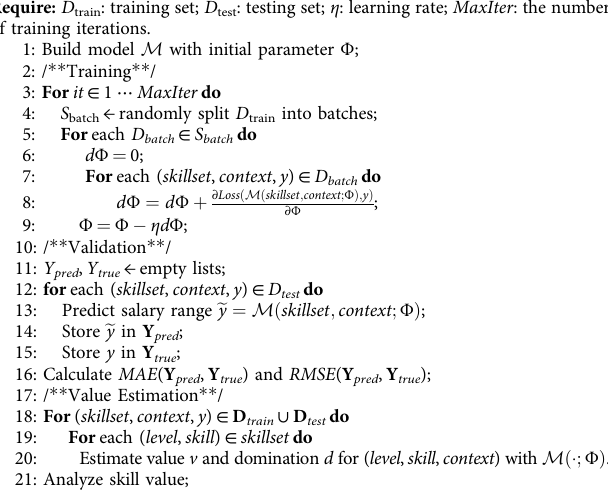
Algorithm 1 . Overall